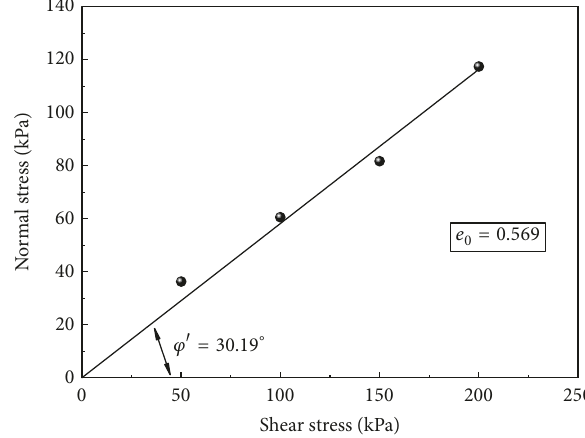
Figure 8: Shear stress against normal stress at peak state (𝑒 0 = 0.569)